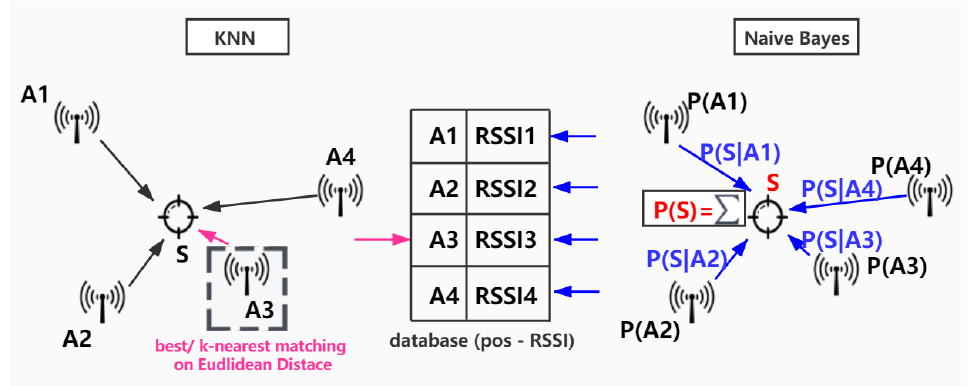
Figure 2. Comparison of fingerprinting KNN and Naive Bayes methods collecting RSSI data from existing